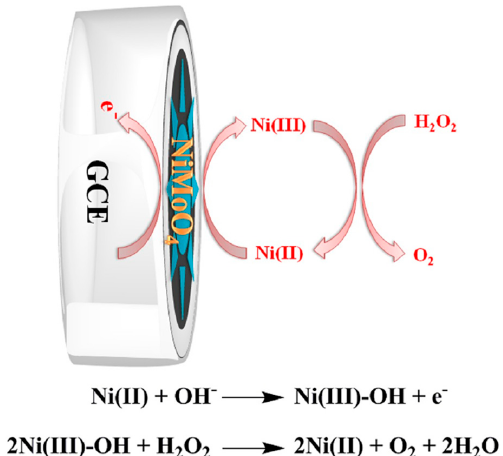
Figure 8. Scheme of NiMnO 4 /GCE mechanism to oxidize the H 2 O 2 [80]. Copyright: Elsevier B.V.